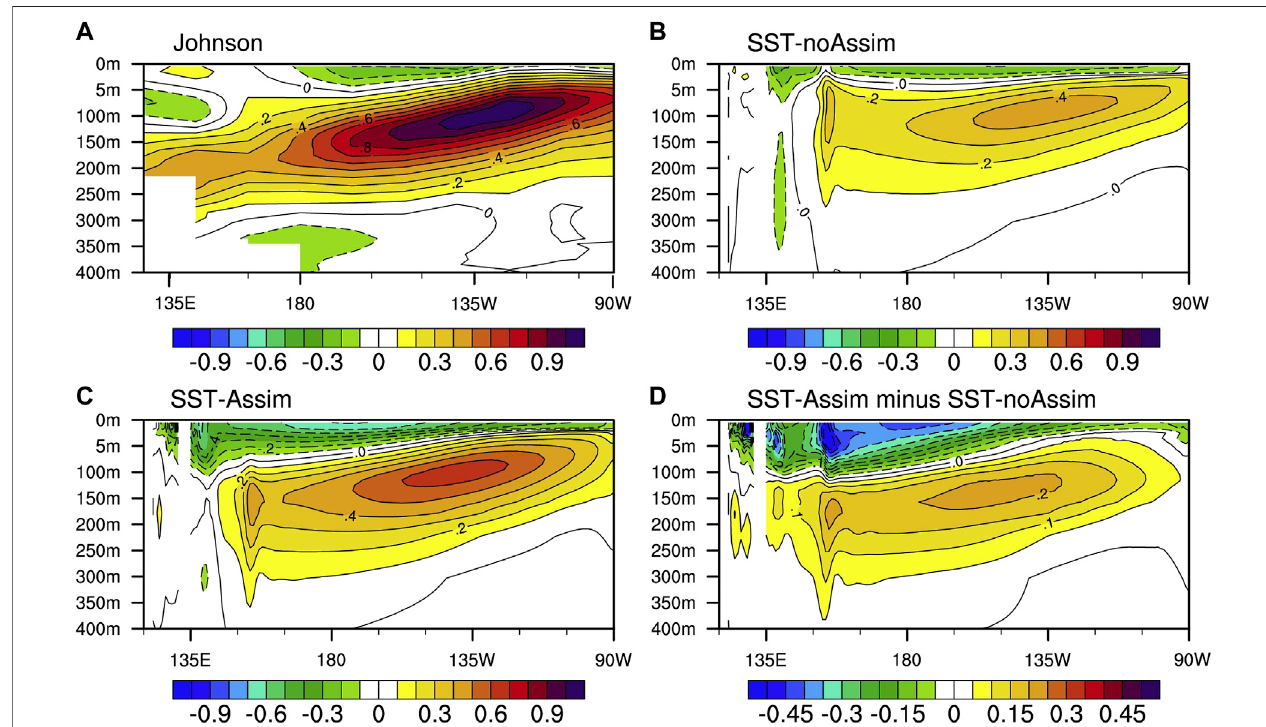
FIGURE 3 | Longitude – depth diagram of annual mean zonal current (shaded and contour; in m/s; eastward in solid, and westward in dashed lines) at the equator (0 ° N) for (A) Johnson data, (B) SST-noAssim experiment and (C) SST-Assim experiment, respectively; (D) The difference between SST-Assim experiment and SST- noAssim experiment (SST-Assim minus SST-noAssim). The average period for the model data is from 1985 to 2000, and the positive values indicate an eastward